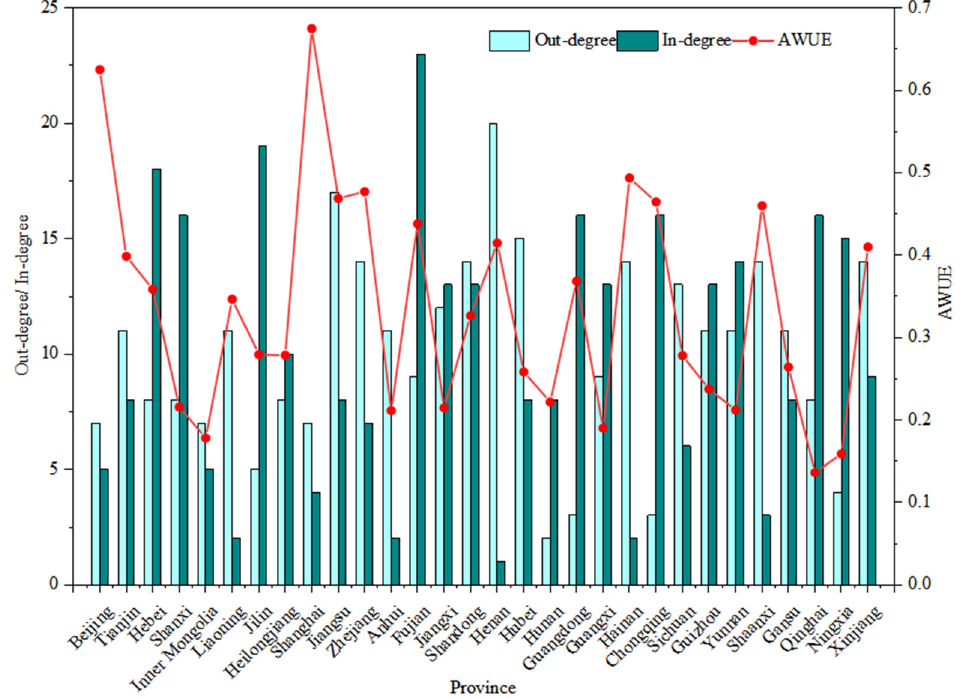
Figure 7. Spillover and reception correlation network of agricultural water use efficiency (AWUE) in China.